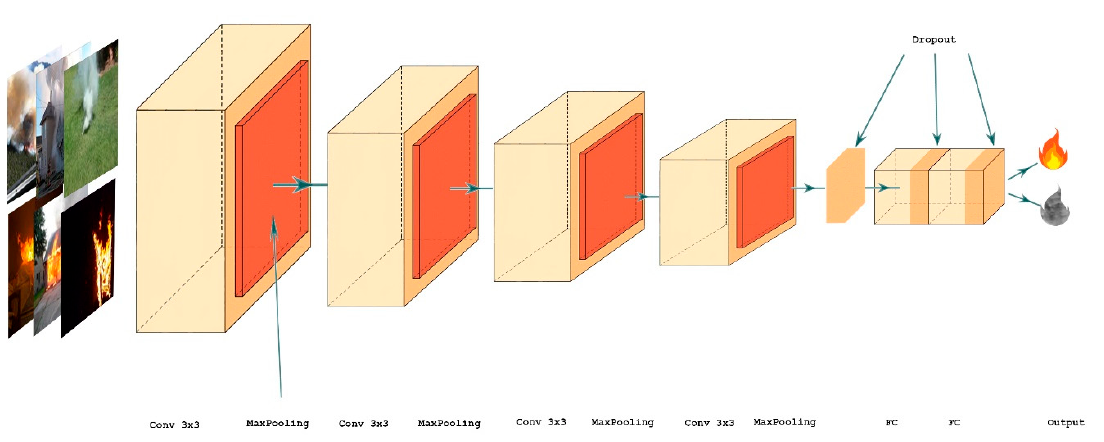
Figure 4. Structure of the network based on dilated convolutional neural networks.